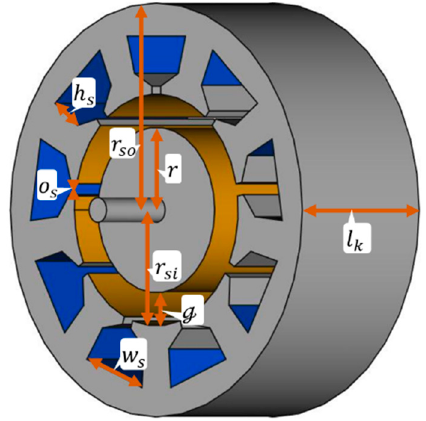
Figure 12. Motor and the parasitic capacitance respective interactive areas.